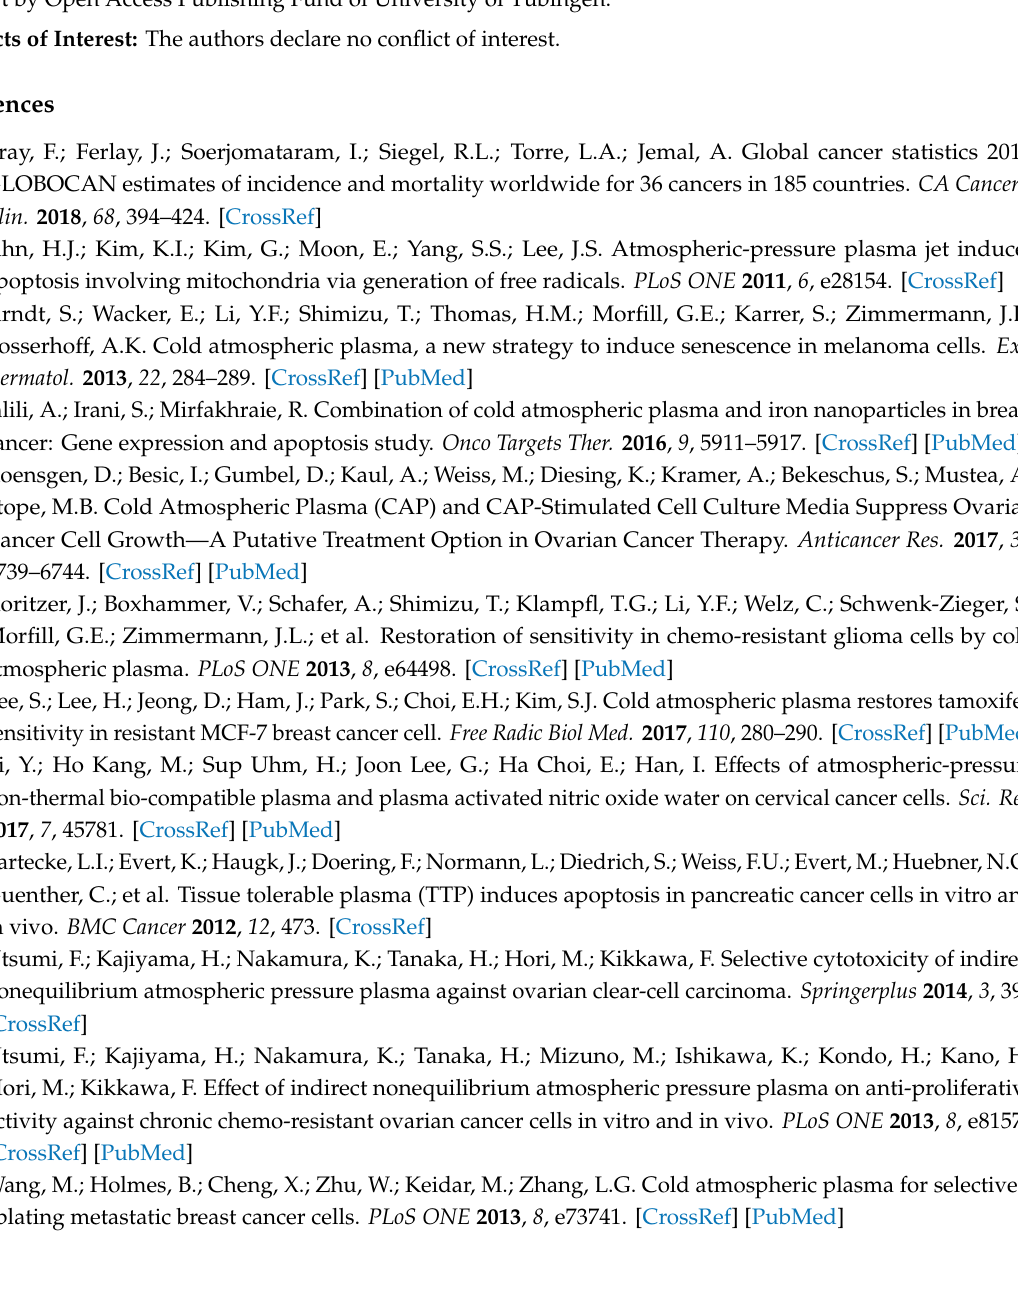
Figure S1: Infrared thermography and OES measurement of the non-thermally operated MABS. Figure S2: Characterization of NCCT cells. Figure S3: NCCT cells are less sensitive to MABS compared to CC